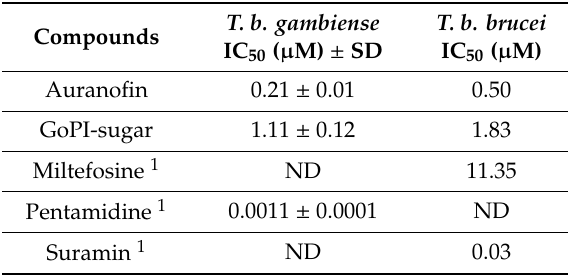
Table 6. In vitro activities of gold(I) complexes in T . b . gambiense and T . b . brucei trypomastigotes.